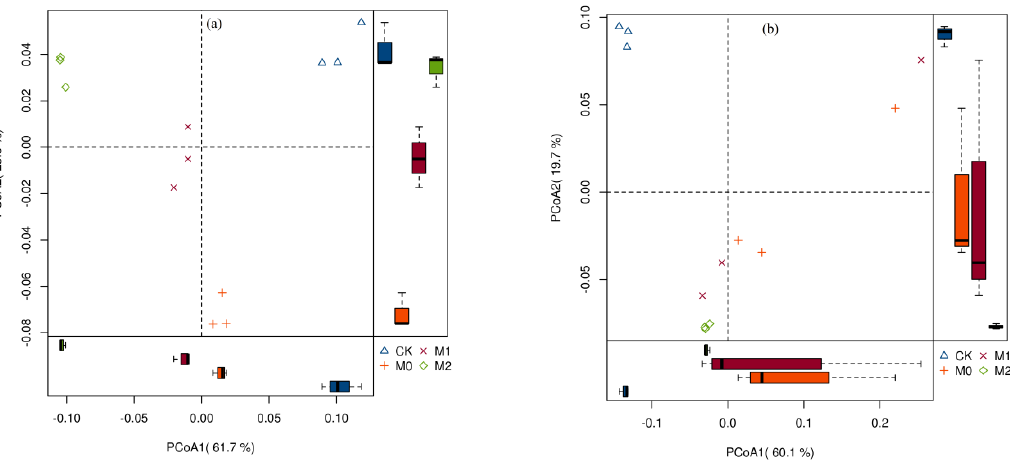
Figure 4. The beta-diversity of the bacterial community in topsoil ( a ) and subsoil ( b ) soil layer under different land use types.